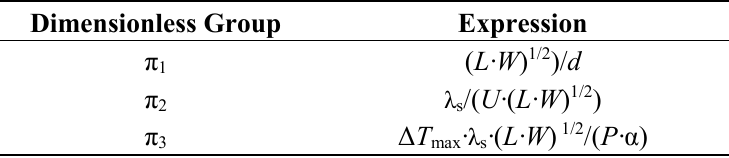
Table 4. Dimensionless groups for describing the laser-induced heating effect (Unit: SI). Dimensionless